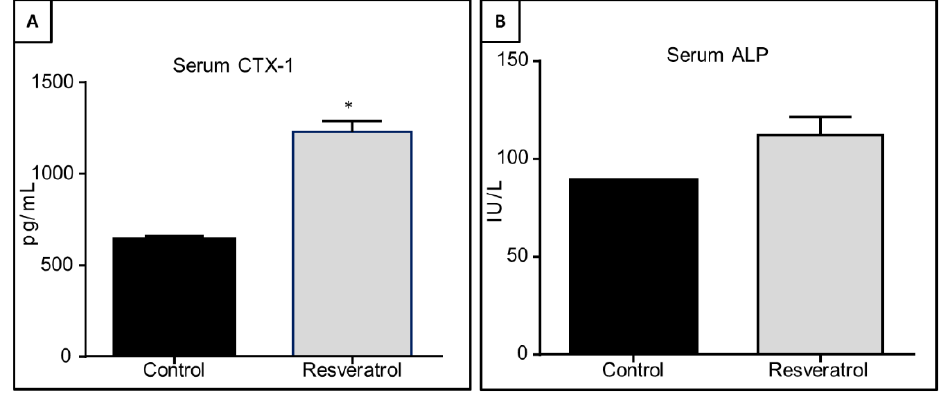
Figure 5. Effects of resveratrol supplementation on serum levels of bone resorption marker collagen type I cross-linked C-telopeptide (CTX-1) and bone formation marker alkaline 12hosphatase (ALP) in the ageing rats. Serum levels of ( A ) CTX-1 ( p = 0.02); ( B ) ALP ( p =